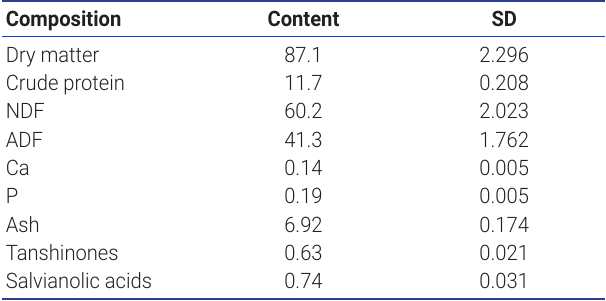
Table 1. Chemical compositions of Salvia miltiorrhiza aerial parts (% of dry matter) Composition